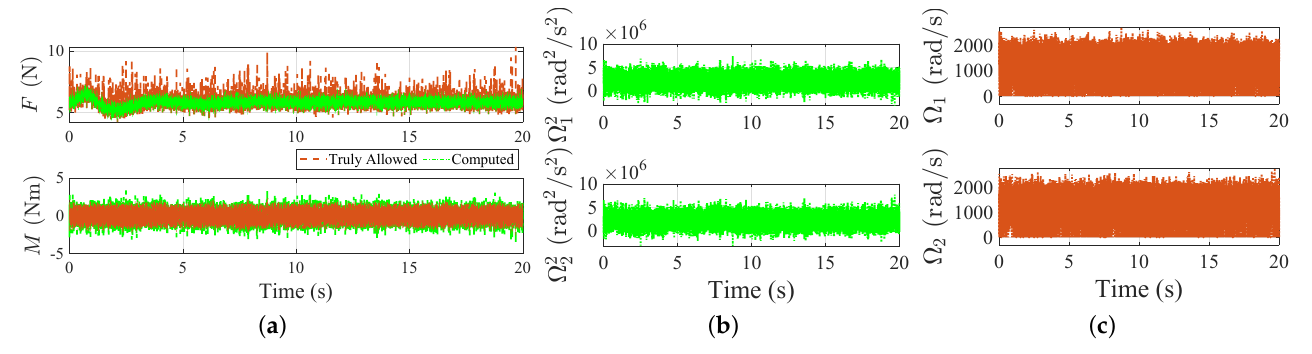
Figure 7. Comparison of computed and truly allowed controls and rotor speeds for the CPID. ( a ) comparison of the computed and truly allowed controls (CPID); ( b ) square of computed rotor speeds; ( c ) truly allowed rotor speeds.